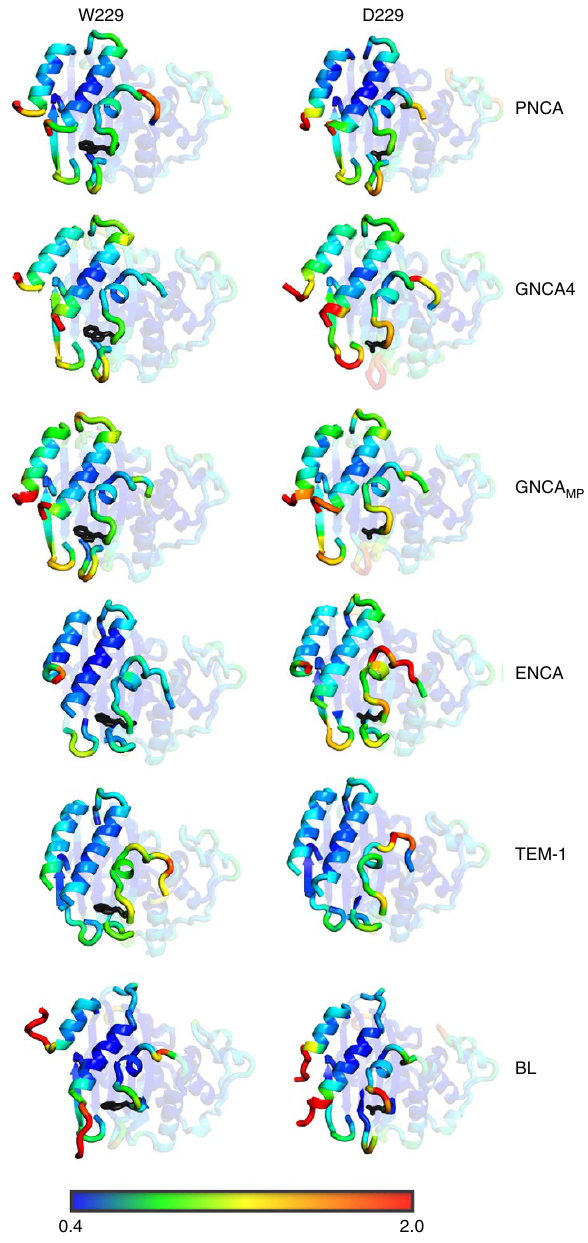
Figure 9 | Tertiary structures of key b -lactamases coloured by RMSF. Shown here are the tertiary structures of the (left) wild-type and (right) variant forms of the TEM-1, ENCA, Bacillus licheniformis , GNCA MP , GNCA4 and PNCA b -lactamases, coloured by the calculated root mean square fluctuations (RMSF) of their C a atoms, based on the values shown in Fig. 8. The colour scale at the bottom of this figure shows the calculated RMSF, in Å. This figure is presented to allow for a visual comparison of the relative mobilities of the different enzymes relative to each other, and how this maps on to their tertiary structures. Note here that the Bacillus licheniformis b -lactamase has unstructured C- and N-terminal segments. The structures shown here are the most representative structures obtained from our molecular dynamics simulations, obtained from clustering analysis as described in the Methods